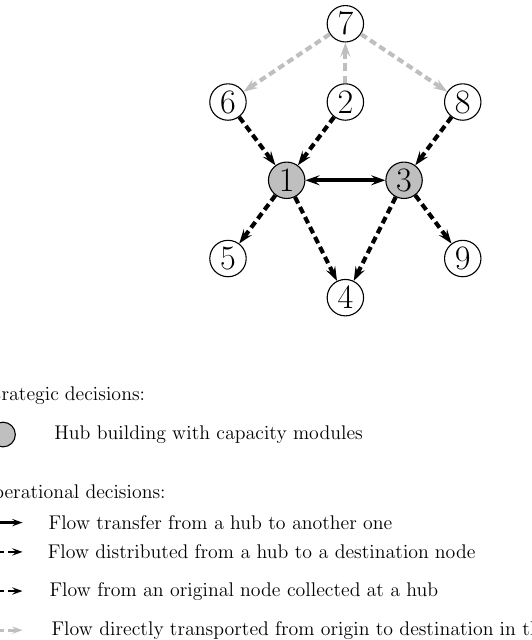
Figure 1. Origin and destination network nodes and hubs representation. Operational